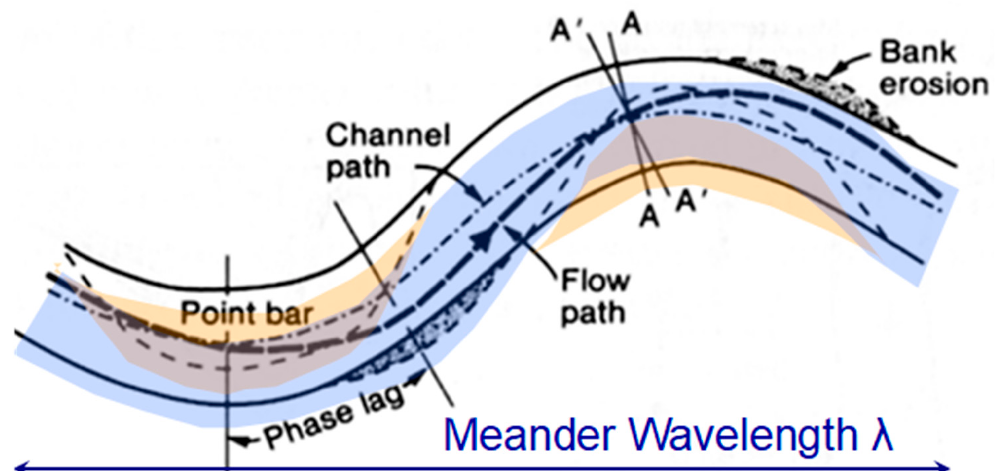
Figure 3. Planform phase lag definition sketch.